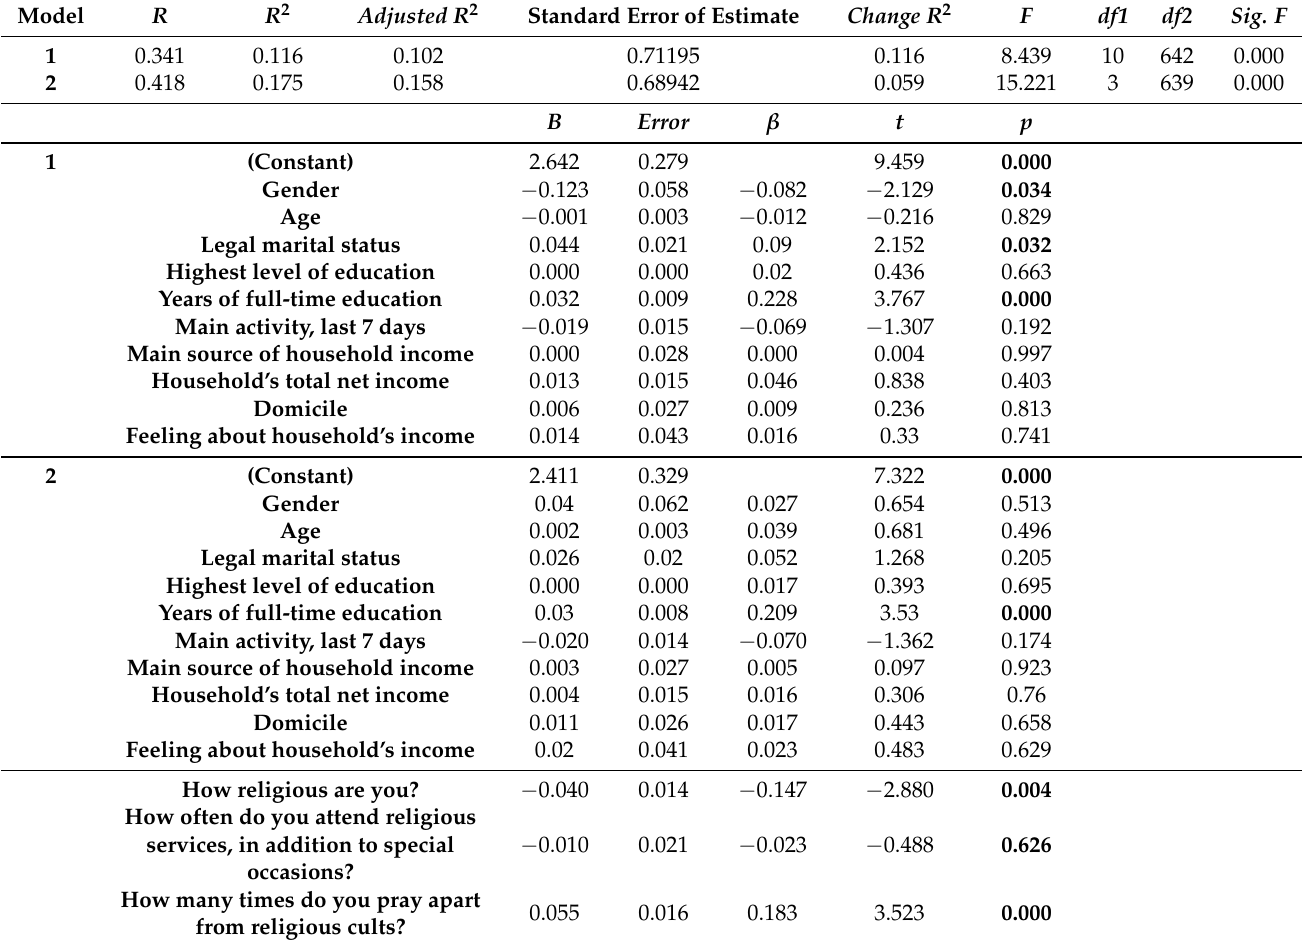
Table 5. Multiple linear regression 1: Contribution to the explanation of the second-order dimension conservation.